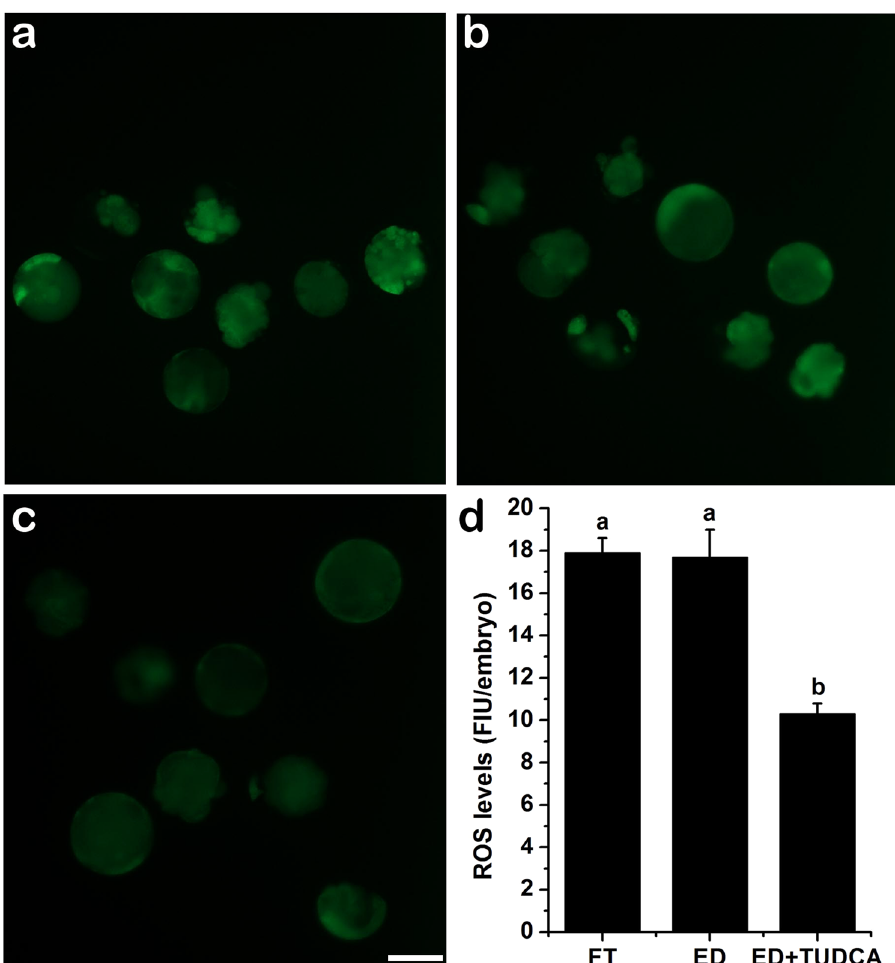
Figure 1. Effect of TUDCA supplementation during embryo culture on the levels of intracellular reactive oxygen species (ROS) in porcine blastocysts. Representative fluorescence images of blastocysts from in vitro matured oocytes fertilized using ICSI with the conventional freeze-thaw (FT) boar spermatozoa without TUDCA-treatment ( a ), evaporatively dried boar spermatozoa without TUDCA-treatment ( b ) or evaporatively dried boar spermatozoa with 200 μ M TUDCA-treatment ( c ). Bar: 100 μ m. d. ROS contents were quantified as fluorescent intensity for three independent times. Each time 6–12 blastocysts were measured. Each bar represents the mean ± SD of the fluorescent density. Bars that do not share the same letter are significantly different at p <